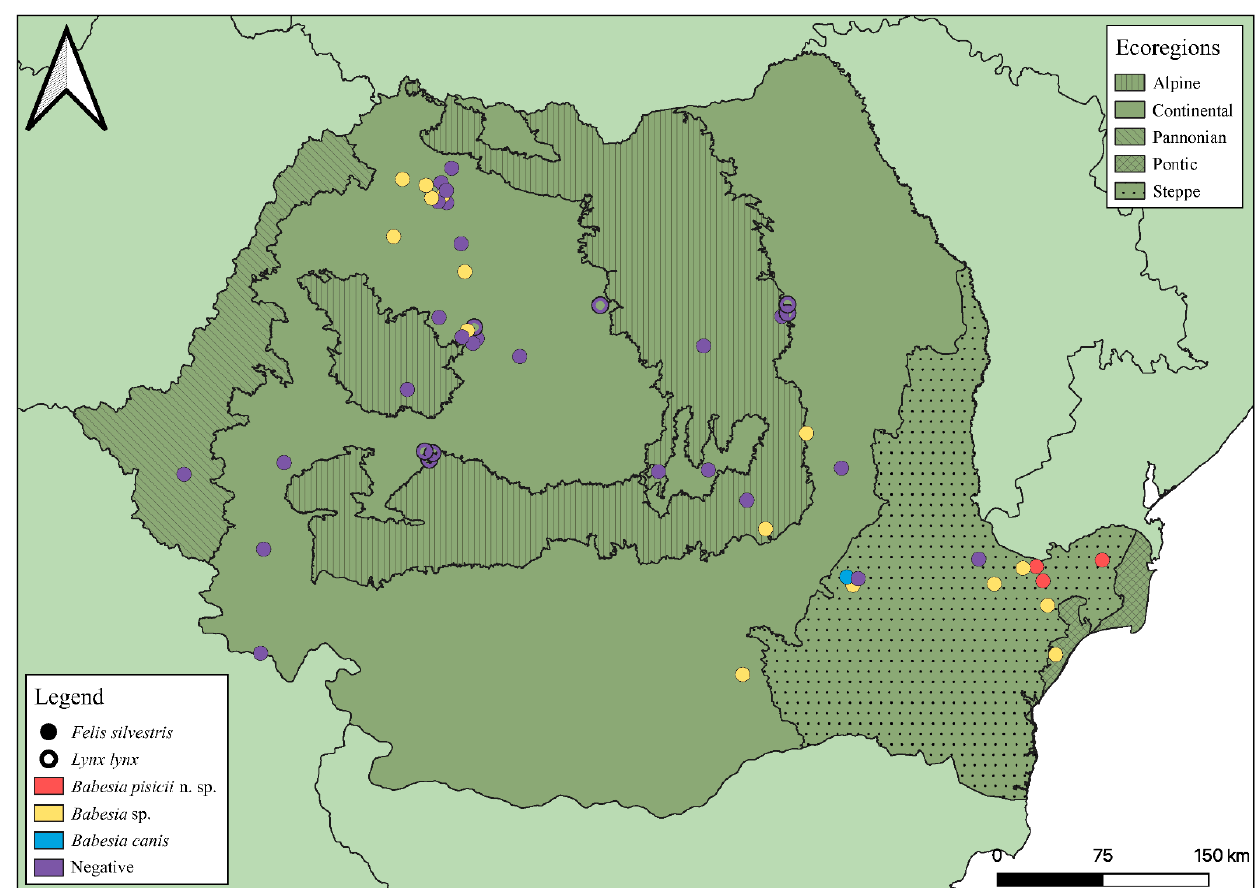
Figure 1. Geographical distribution of the samples included in the study and their positivity to Babesia sp. (samples that yielded a positive result in the assay targeting 18S rDNA fragment of 376 bp), B. canis , and B. pisicii n. sp. (confirmed by mitochondrial genes analysis).